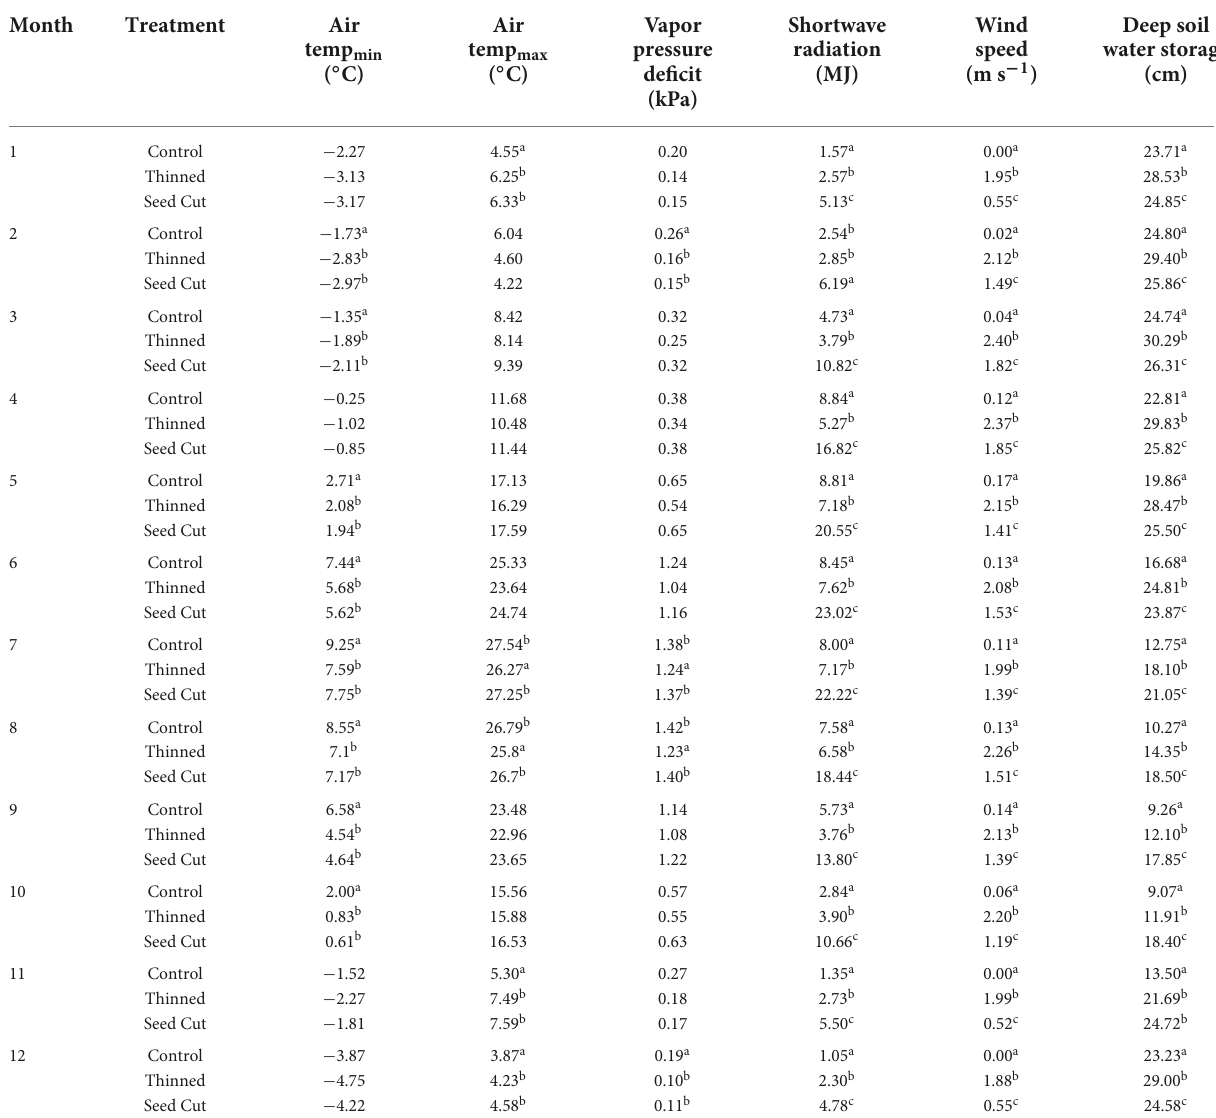
TABLE 3 Median monthly parameter values at monitoring